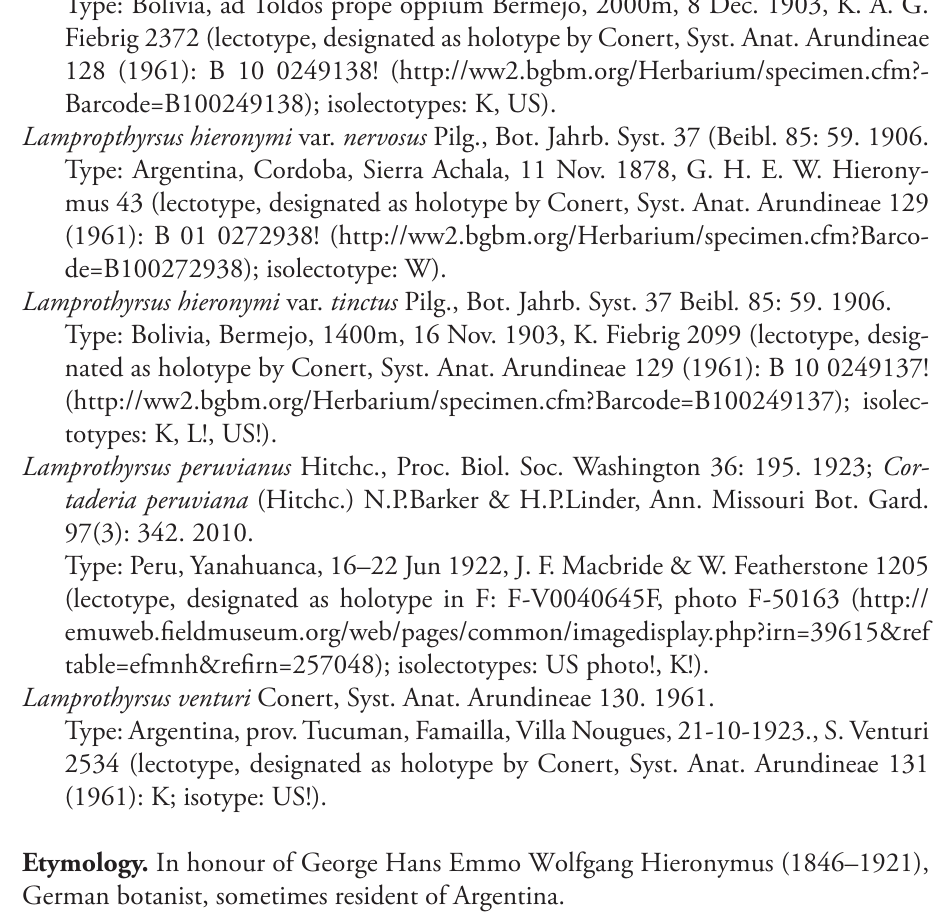
table=efmnh&refirn=257048); isolectotypes: US photo!, K!). Lamprothyrsus venturi Conert, Syst. Anat. Arundineae 130. 1961. Type: Argentina, prov. Tucuman, Famailla, Villa Nougues, 21-10-1923., S. Venturi 2534 (lectotype, designated as holotype by Conert, Syst. Anat. Arundineae 131 (1961): K; isotype: